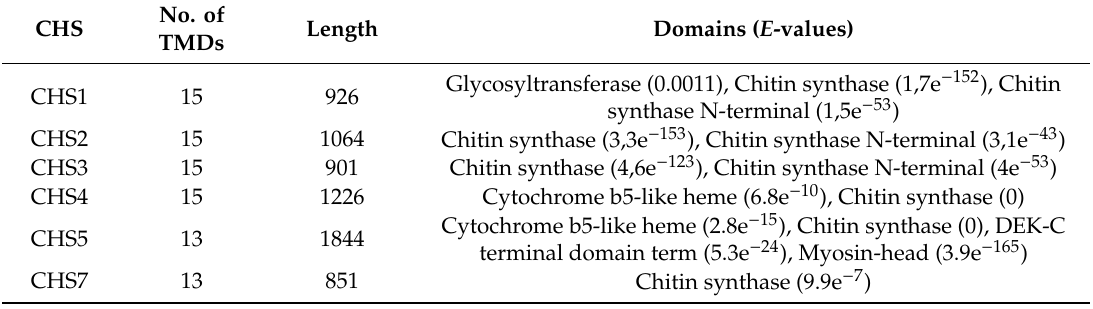
Table 3. D. teres CHS with predicted transmembrane domains (TMDs), deduced protein lengths and predicted domains.